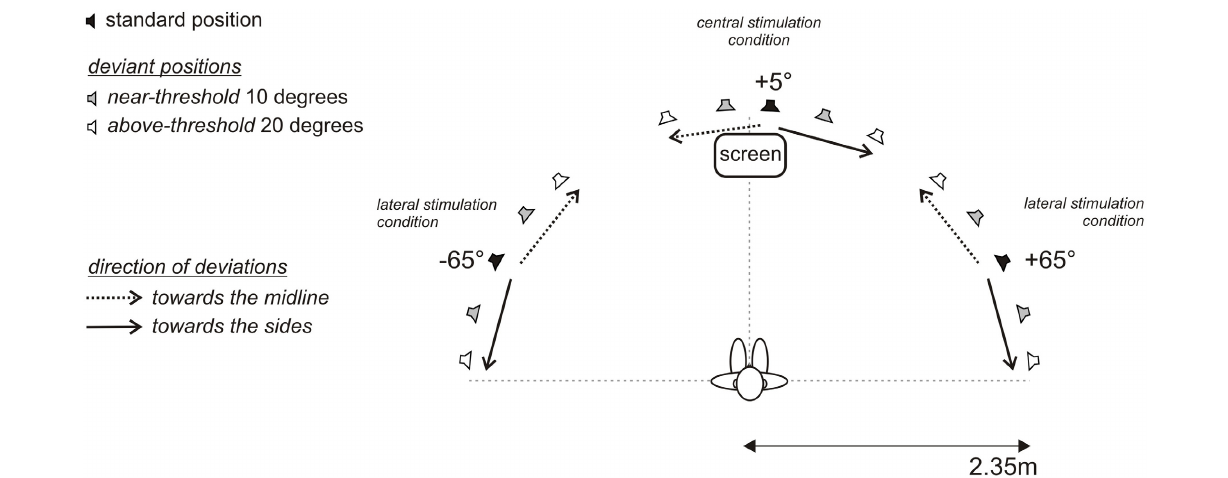
FIGURE 1 | Free-field setup with 33 loudspeakers in a semicircular array positioned between 85 ◦ to the left ( − ) and 85 ◦ to the right ( + ). Acoustic targets of defined lateral positions were established by activation of a single loudspeaker or crossfading the inputs to two neighboring speakers. Subjects were seated in the center of the semicircle with the head oriented straight and looking at a fixation cross at 0 ◦ (vertical dashed line); the interaural axis extended to the positions − 90 ◦ and + 90 ◦ ,